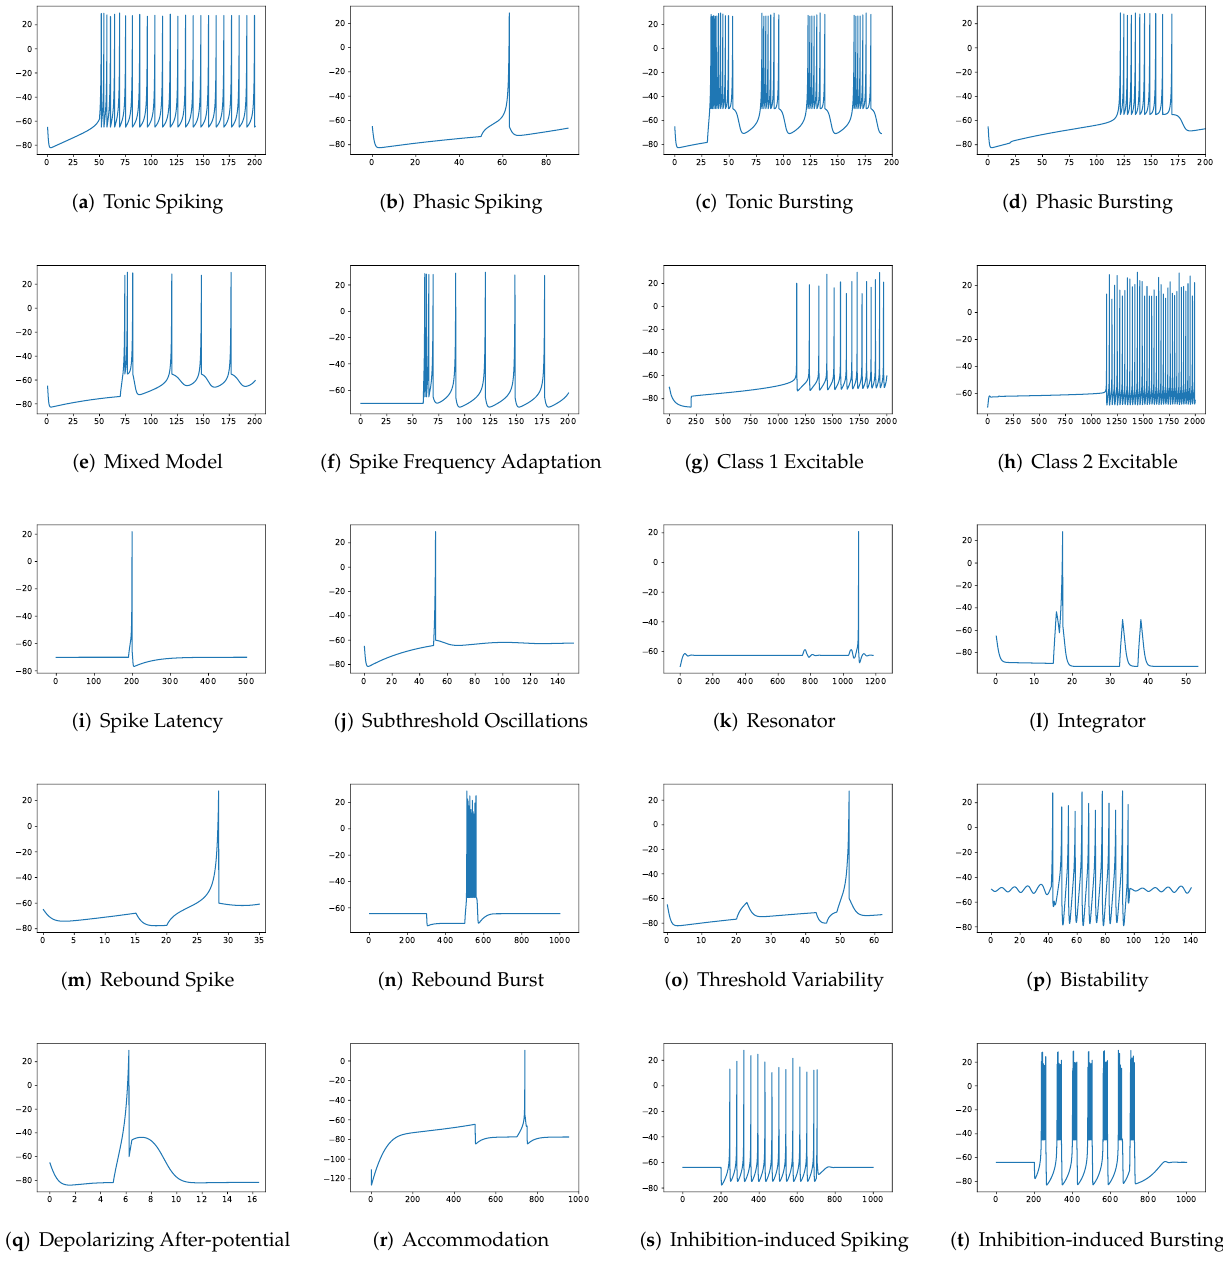
Figure 1. Twenty firing behaviors generated by the Izhikevich Model, where y-axis is the membrane potential (mV) and x-axis is the time